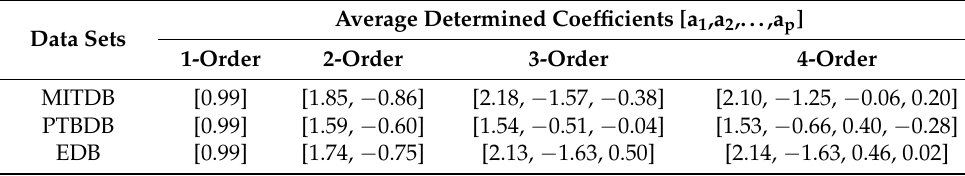
Table 5. Average Determined Linear Prediction Coefficients.